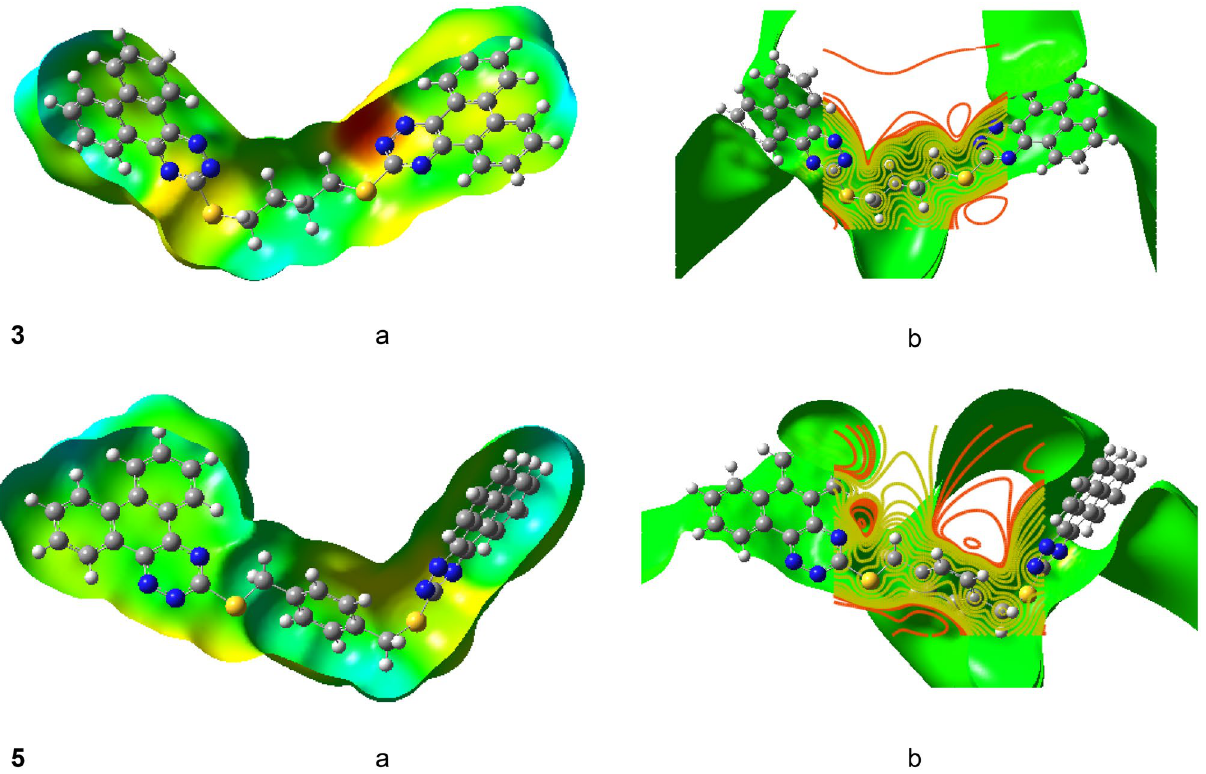
Figure 4. Molecular electrostatic potential ( a ) and electrostatic potential ( b ) surfaces of 3 and 5 using B3LYP/6-311G ** .